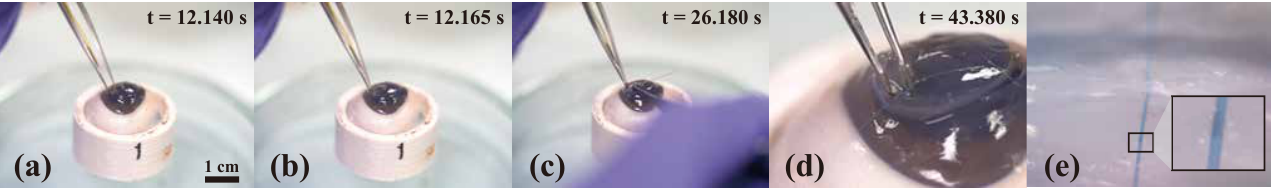
Figure 6. Suturing on the porcine cornea. ( a ) Just before the device’s tip reaches the target depth. ( b ) Just after the device’s tip reaches the target depth and the device grasp the cornea. ( c ) Needle insertion. ( d ) After pulling the needle, the suture is generated. ( e ) Microscopic image of the side surface of the corneal tissue. An exit point of the suture can be observed in the magnified